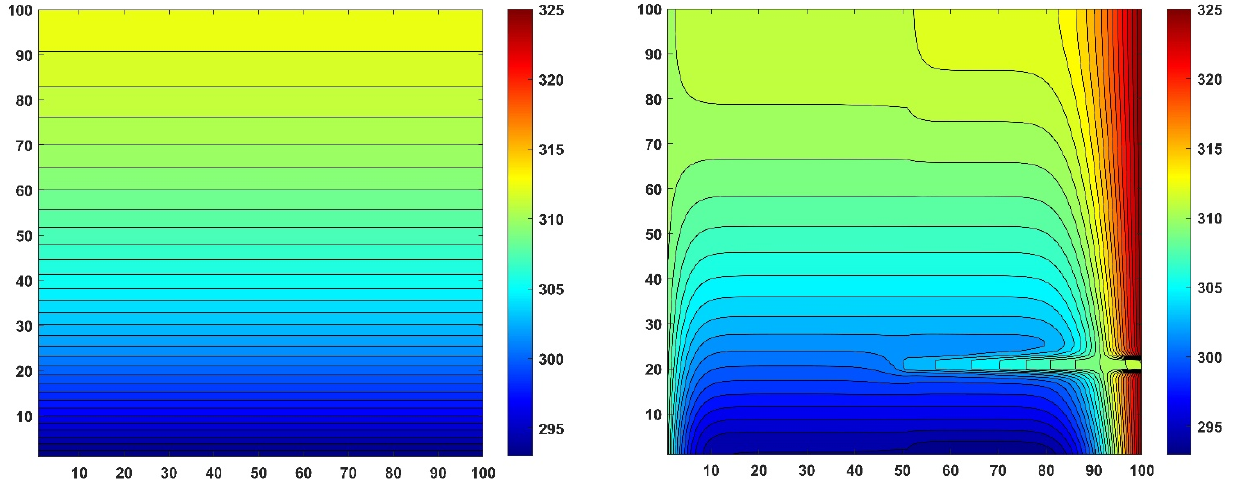
Figure 18. The distribution contour of the temperature in Kelvin for the non-equidistant mesh at initial (left) and final time (right), in the case of the multilayer cross-sectional area (Experiment 8). The numbers on the vertical and horizontal axes of the contours are the coordinates in cm units. Experiment 9—high-temperature boundary conditions, non-equidistant